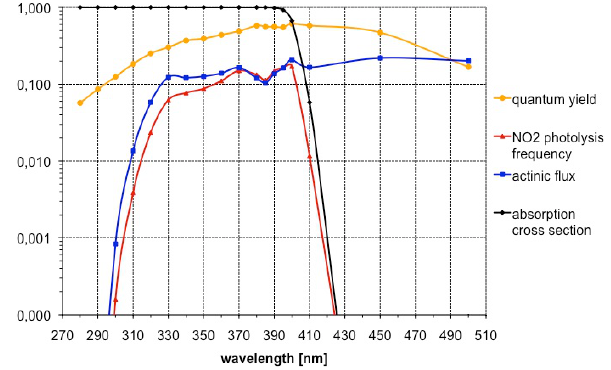
Fig. 3. Spectral values of NO 2 photolysis frequency and of its con- tributors in relative